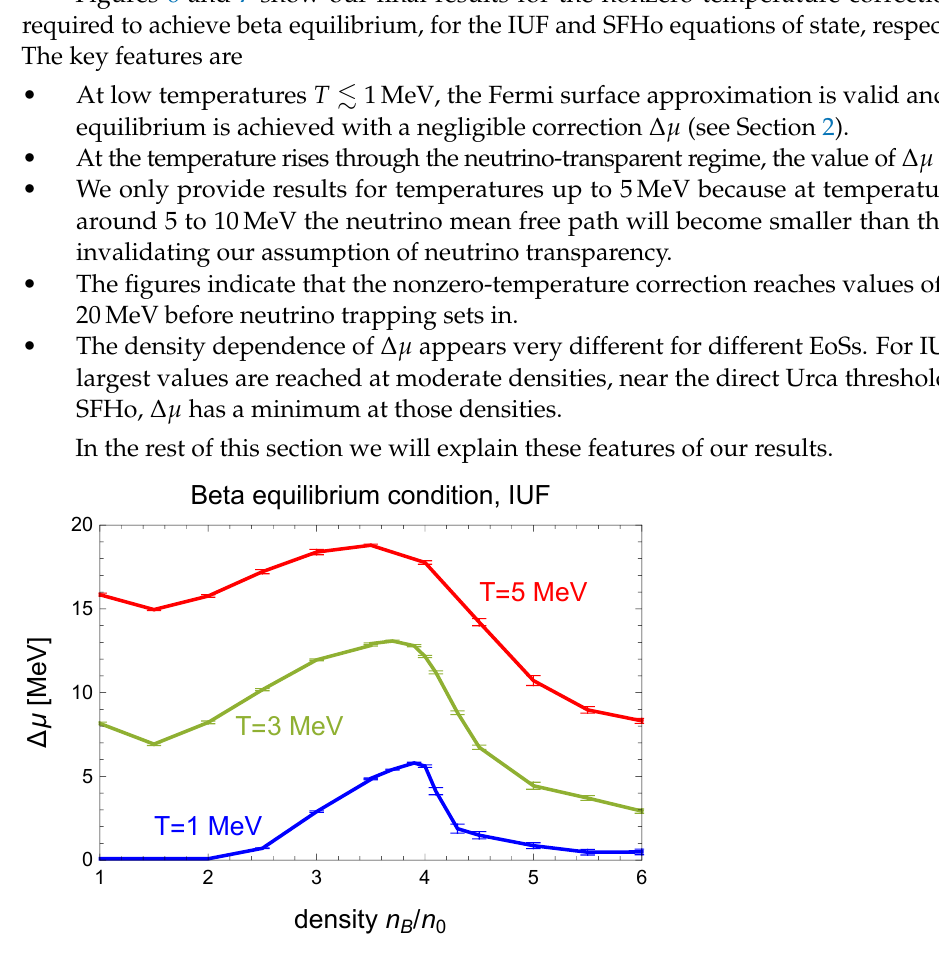
Figure 6. Nonzero-temperature correction ∆ µ required for beta equilibrium Equation (7) with the IUF EoS.